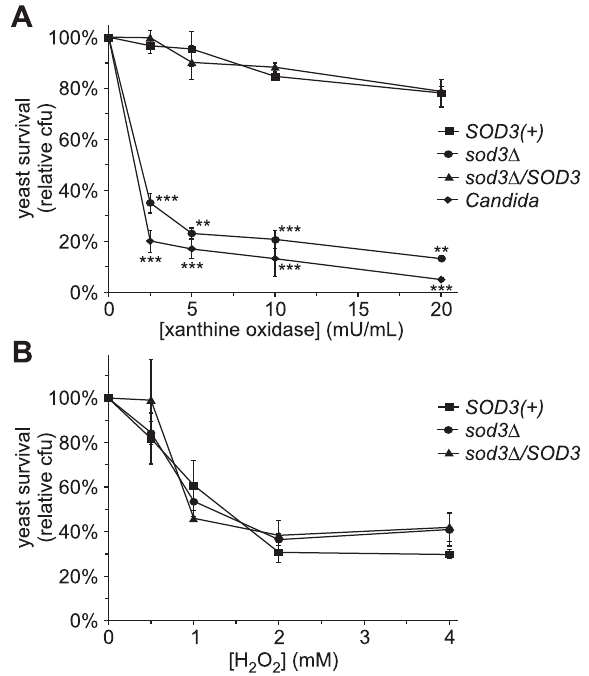
Figure 4. Sod3 protects Histoplasma yeast cells from exogenous superoxide in vitro. ( A ) Survival of yeast cells following challenge with superoxide. Yeasts were incubated in increasing amounts of superoxide generated by addition of increasing amounts of xanthine oxidase to hypoxanthine. SOD3( + ) (OSU45), sod3 D (OSU15), sod3 D /SOD3 (OSU49), and Candida albicans yeasts were incubated for 4 hours at 37 u C after which viable colony forming units (cfu) were determined. Results are plotted as relative yeast survival compared to viable cfu of yeasts incubated in the absence of superoxide (0 mU/mL xanthine oxidase). Results represent the mean 6 standard deviations from 3 replicate challenges per strain. Asterisks indicate significant differences (** p , 0.01, *** p , 0.001) from the SOD3( + ) strain. ( B ) Sensitivity of Histoplasma yeasts to hydrogen peroxide. Increasing amounts of hydrogen peroxide were added to Histoplasma yeasts (n=3 for each strain) at 37 u C and the viability of yeasts after 4 hours was determined by enumeration of viable cfu. Results are plotted as relative yeast survival compared to viable cfu of yeasts incubated in the absence of peroxide (0 mM hydrogen peroxide). Data is representative of 3 independent experiments.